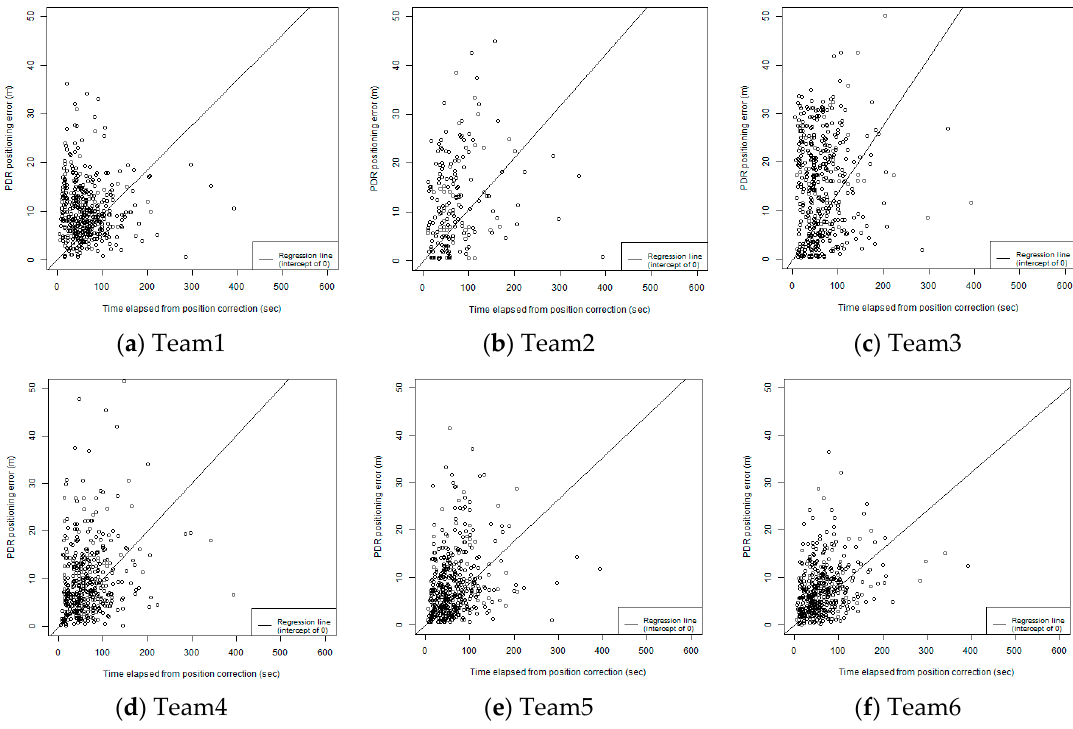
Figure 10. Comparison of slopes of error accumulation estimated by linear regression.